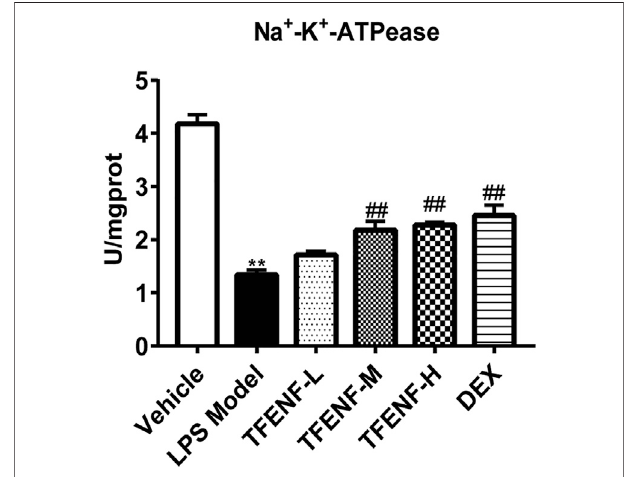
FIGURE 8 | TFENF increased the enzymatic activity of Na + -K + -ATPase in LPS-induced ALI. Increase in the enzymatic activity of Na + -K + -ATPase by TFENF in rat lung tissue 6 h after LPS-induced ALI or saline treatment ( n (cid:2) 6 per group). Data are presented as mean ± S.E.M. **p < 0.01 compared with the vehicle group; ## p < 0.01 compared with the LPS model